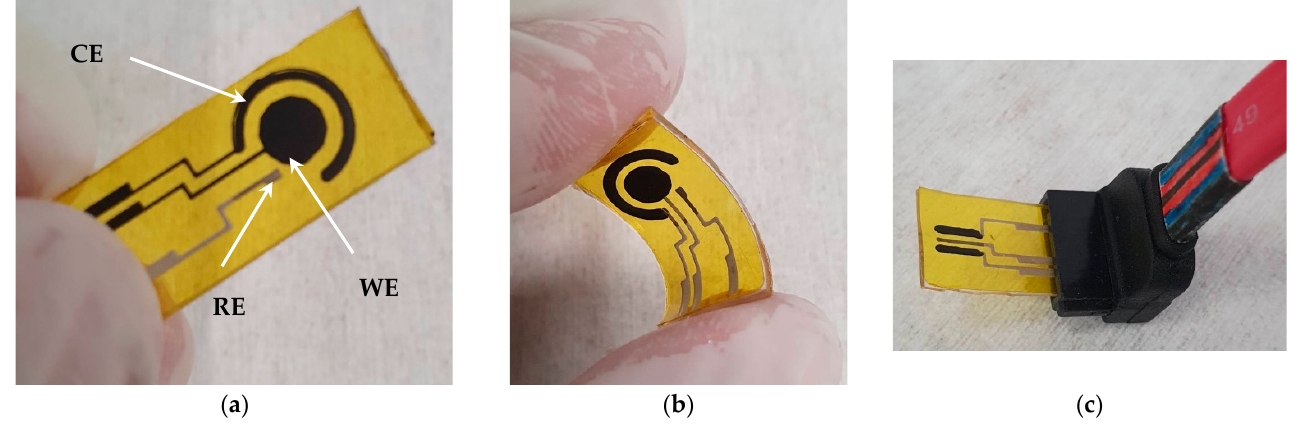
Figure 2. An electrochemical carbon-based sensor on a flexible substrate (25 × 10 mm) with 3 electrodes: ( a ) WE and CE were completely from carbon, and RE was Ag/AgCl; ( b , c ) all electrodes, electric routes, and pads were made from Ag, and in the interest area, WE and CE were covered with carbon paste.